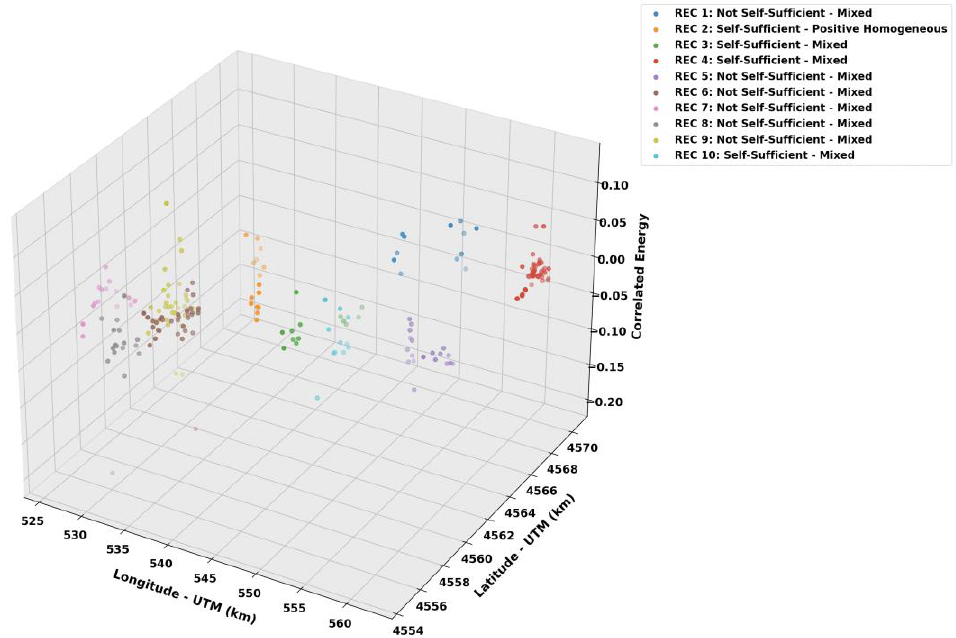
Figure 16. Members distributed by REC—Ward’s method.